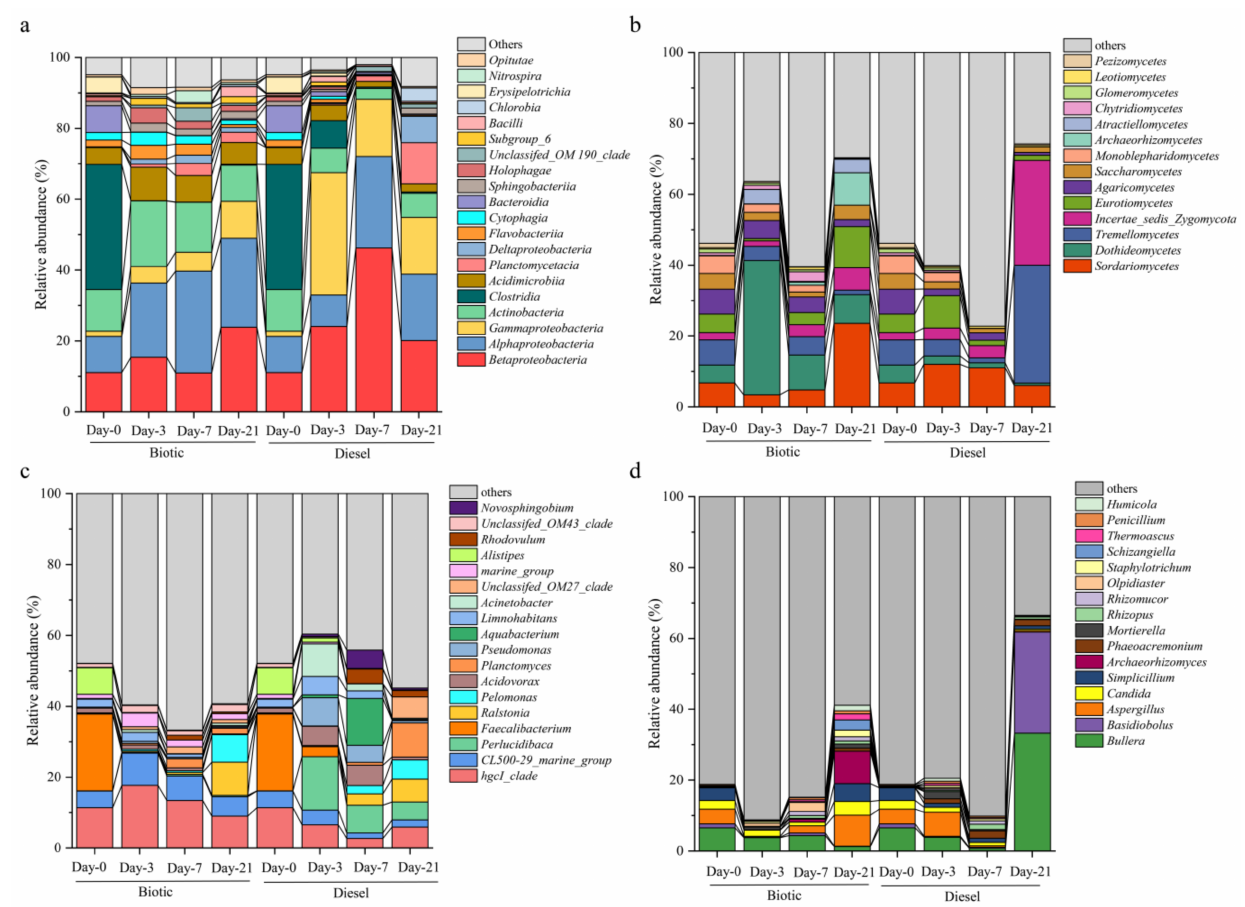
Figure 3. Community composition of bacteria at class ( a ) and genus ( c ) levels and fungi at class ( b ) and genus levels ( d ) in the treatments with (diesel) or without (biotic) diesel. The graphs only present the classes or genera whose relative abundance are >0.2% and >0.01%, respectively. The remaining classes or genera are presented as